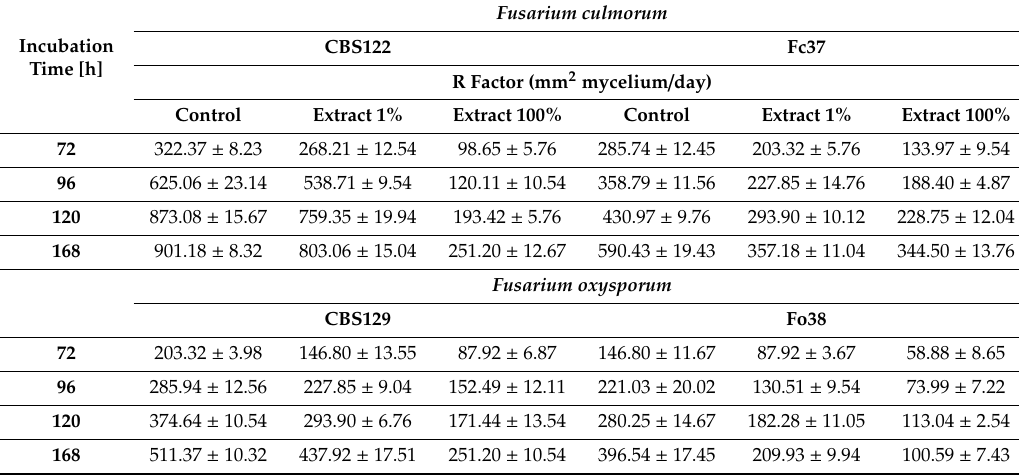
Table 1. The growth rate of Fusarium culmorum (CBS122, Fc37) and Fusarium oxysporum (CBS129, Fo38). strains on potato dextrose agar (PDA) medium with addition of 1% and 100% F. vesiculosus extract after 72, 96, 120 and 168 h of incubation in a comparison with the control. The growth rate was presented as R factor (mm 2 mycelium /